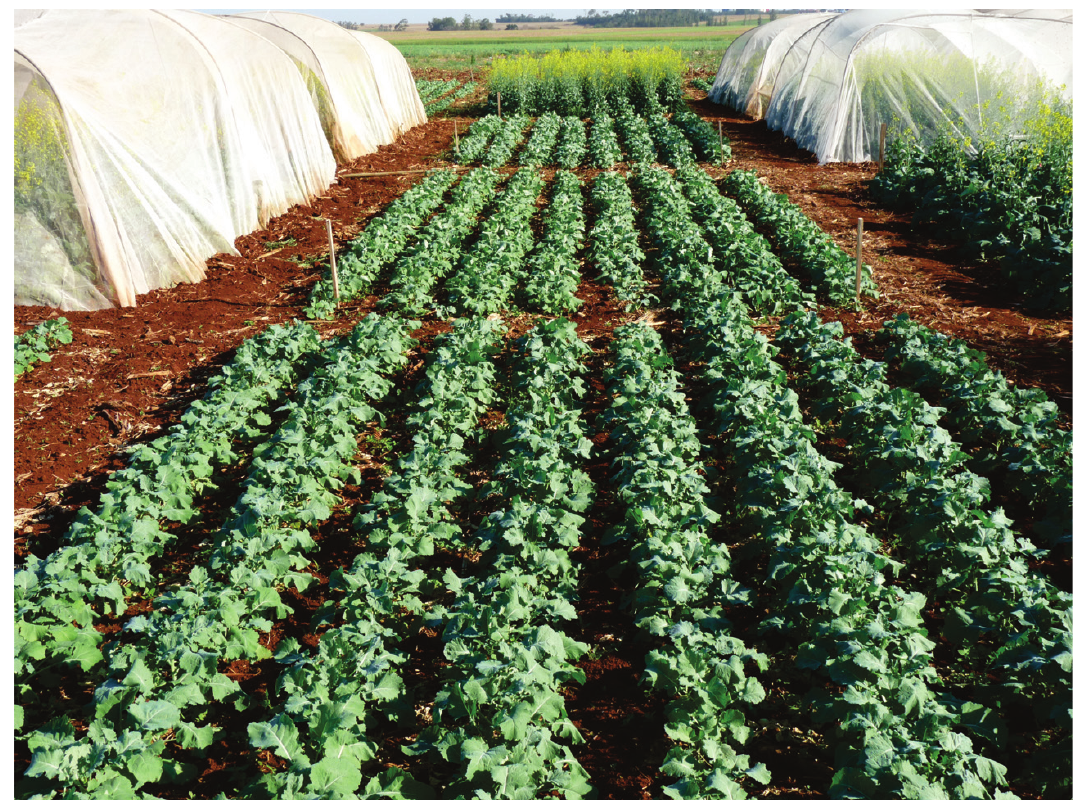
Fig. 2 - Experimental area with pollination